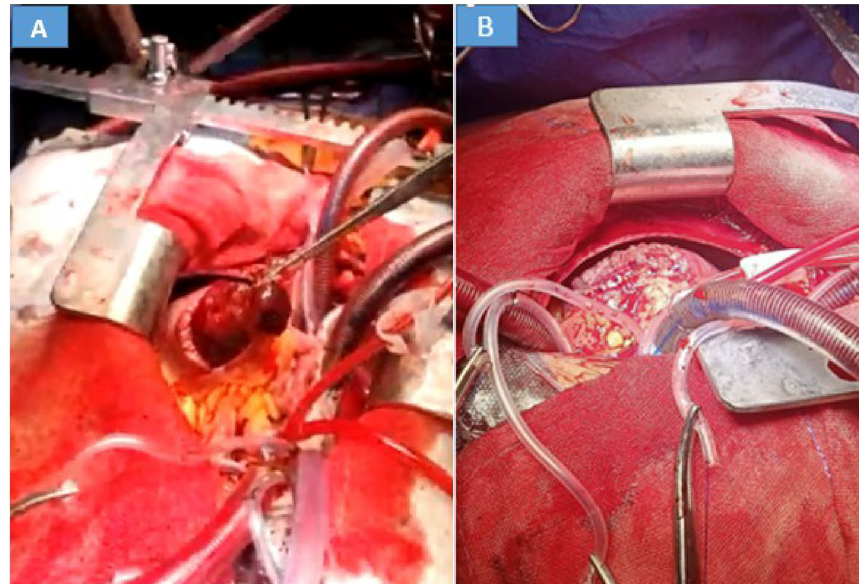
Fig. 3 A The image showing the upper part of the mass delivered through the right ventriculotomy. B The image showing the right ventriculotomy closed with 2 layers of proline sutures, a continuous suturing layer and a pledgeted transverse mattress layer